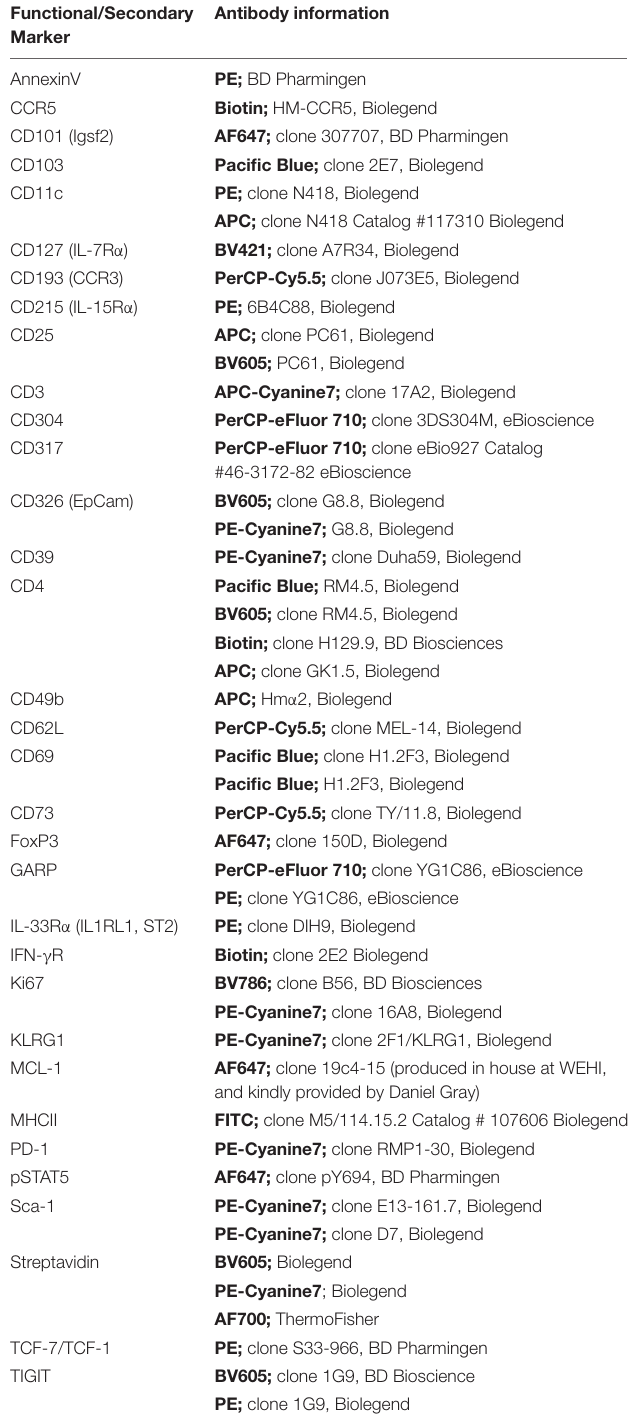
TABLE 1 | Antibodies used for surface and intracellular flow cytometry analysis. Functional/Secondary Antibody Marker